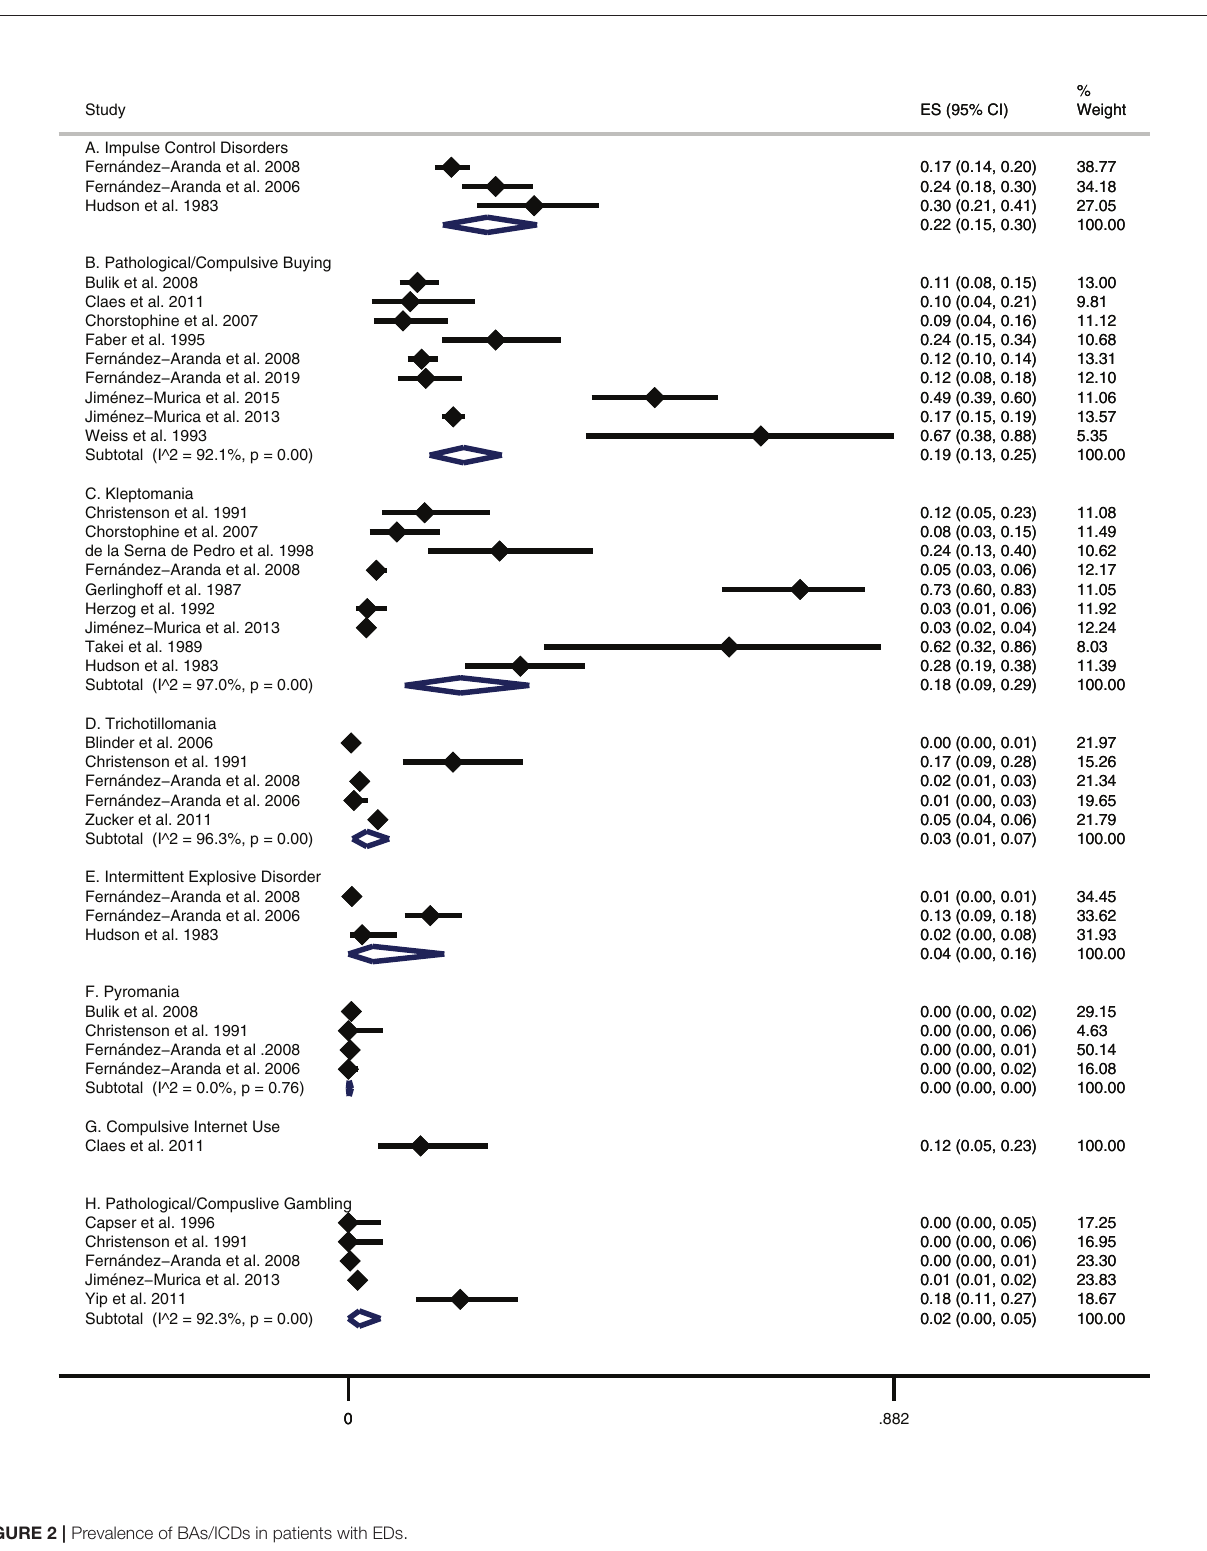
FIGURE 2 | Prevalence of BAs/ICDs in patients with